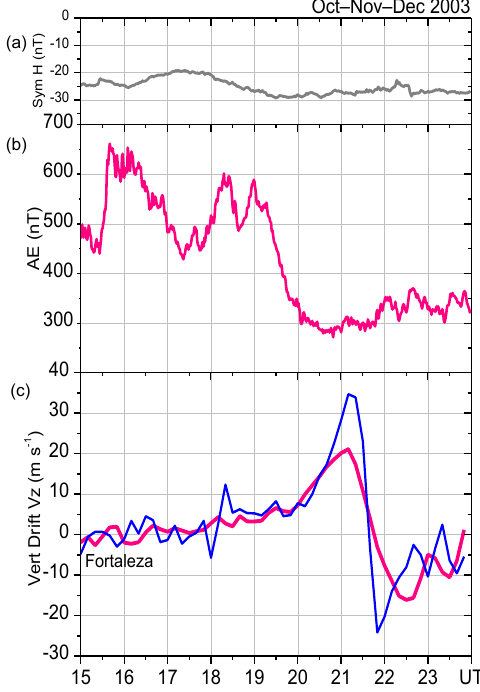
Figure 6. The variations in the mean of the superposed values based on 18 days of V z data over Fortaleza and the corresponding mag- netic indices during the periods October, November and Decem- ber 2003 in: (1) the Sym-H/Dst (a) , (2) the AE index (b) , and the vertical drift V z as mean of 18 days (red curve) and mean of 10 quiet days (blue curve) (c)